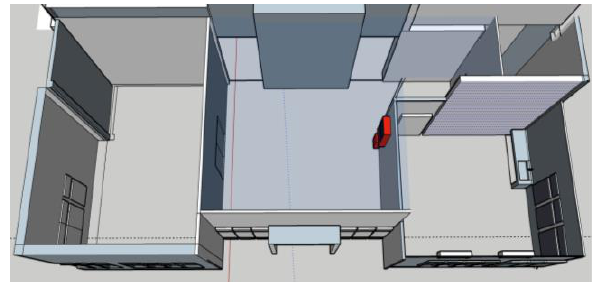
Figure 5 . The representation of unoccupied spaces.